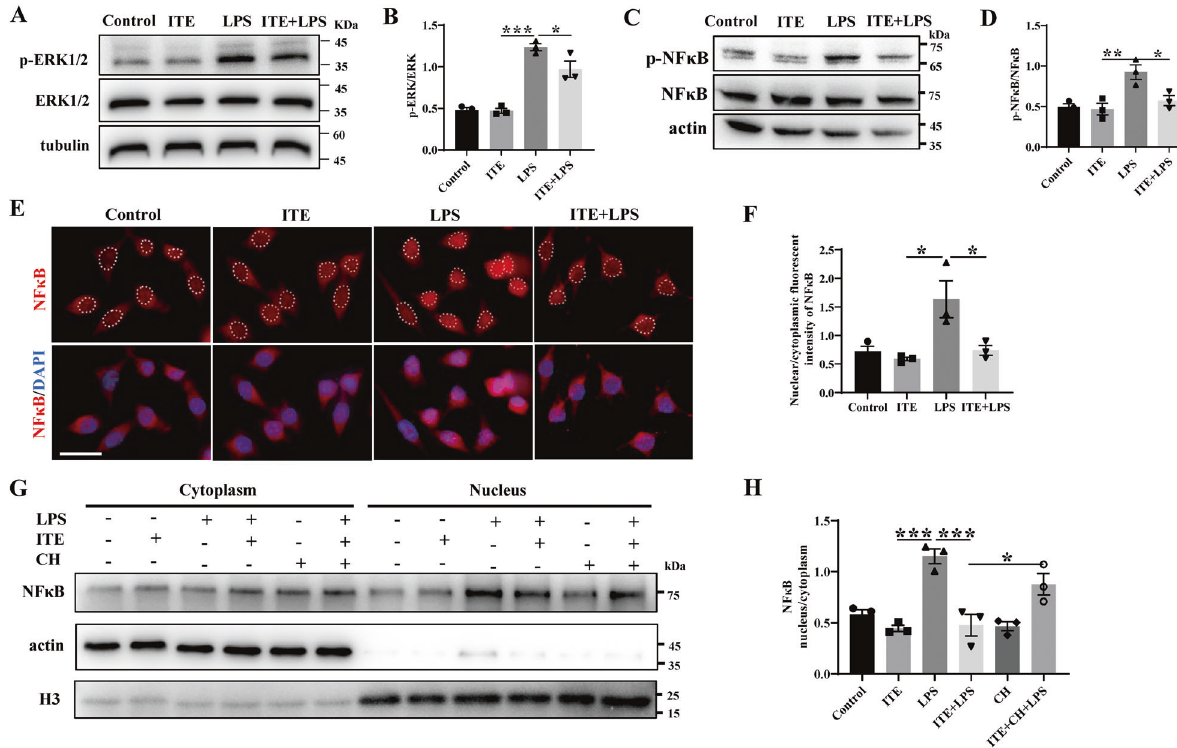
Fig. 7 ITE alleviated LPS induced NF κ B and ERK signaling via AhR activation in BV2 microglia. BV2 cells were pre-treated with ITE for 4 h and followed by LPS for 4 h. A , B Western blot showing the expression of p-ERK and ERK in BV2 microglia of Control, ITE, LPS and ITE + LPS groups. C , D Western blot of each group showing the protein level of p-NF κ B and NF κ B in BV2 microglia. E Immuno fl uorescence staining to detect different nuclear translocation state of NF κ B (red) in each group. Cell nuclei were counterstained with DAPI (blue). Scale bar: 25 μ m. F Quanti fi cation of nuclear/cytoplasmic fl uorescent intensity of NF κ B in four groups. G , H CH223191 was added 24 h before ITE treatment and subcellular fractionation separation experiments was performed. Representative western blot analysis for NF κ B G and quanti fi cation of the ratio of nuclear to cytoplasmic fraction H . All data are presented as mean ± SEM. and are representative of at least three independent experiments. * P < 0.05, ** P < 0.01, *** P < 0.001, P value was obtained by one way ANOVA followed by multiple